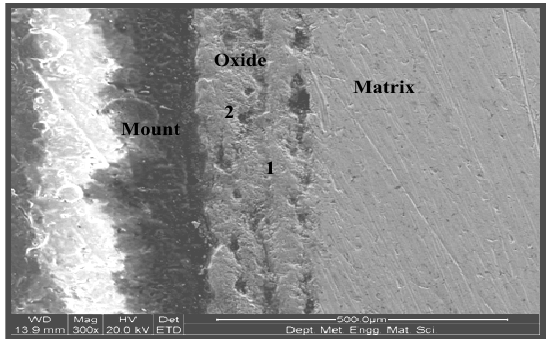
Figure 11. SEM micrograph of the cross section of E911 alloy oxidized at 1073 K.